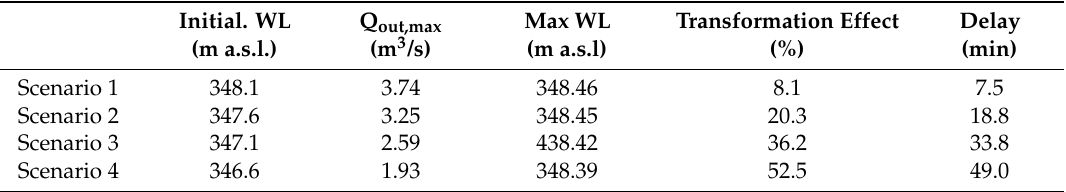
Figure 9. ( a ) Hydrographs of the transformed 100-year flood waves; ( b ) and the corresponding water level elevations. Table 1. Summary of modeling the transformation of a 100-year flood wave through the Vrbovce SWR. Four scenarios with different initial water level elevations were considered.